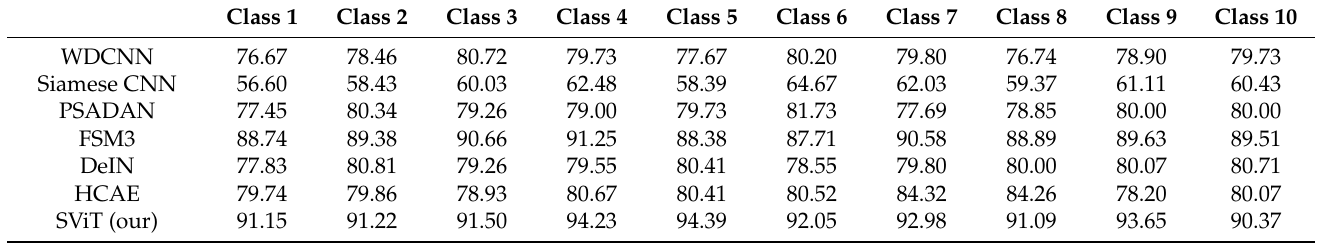
Table 11. F1 score (%) comparison for cross-domain task C-A with 6000 training samples on